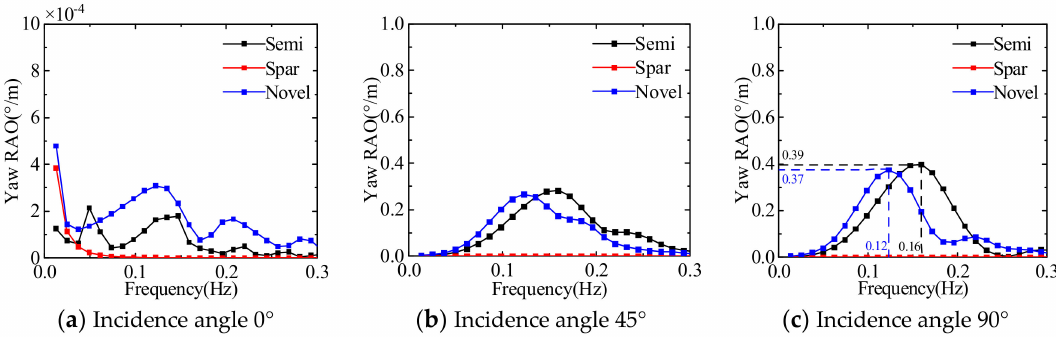
Figure 25. Comparison of the response amplitude operator in yaw direction of three floating